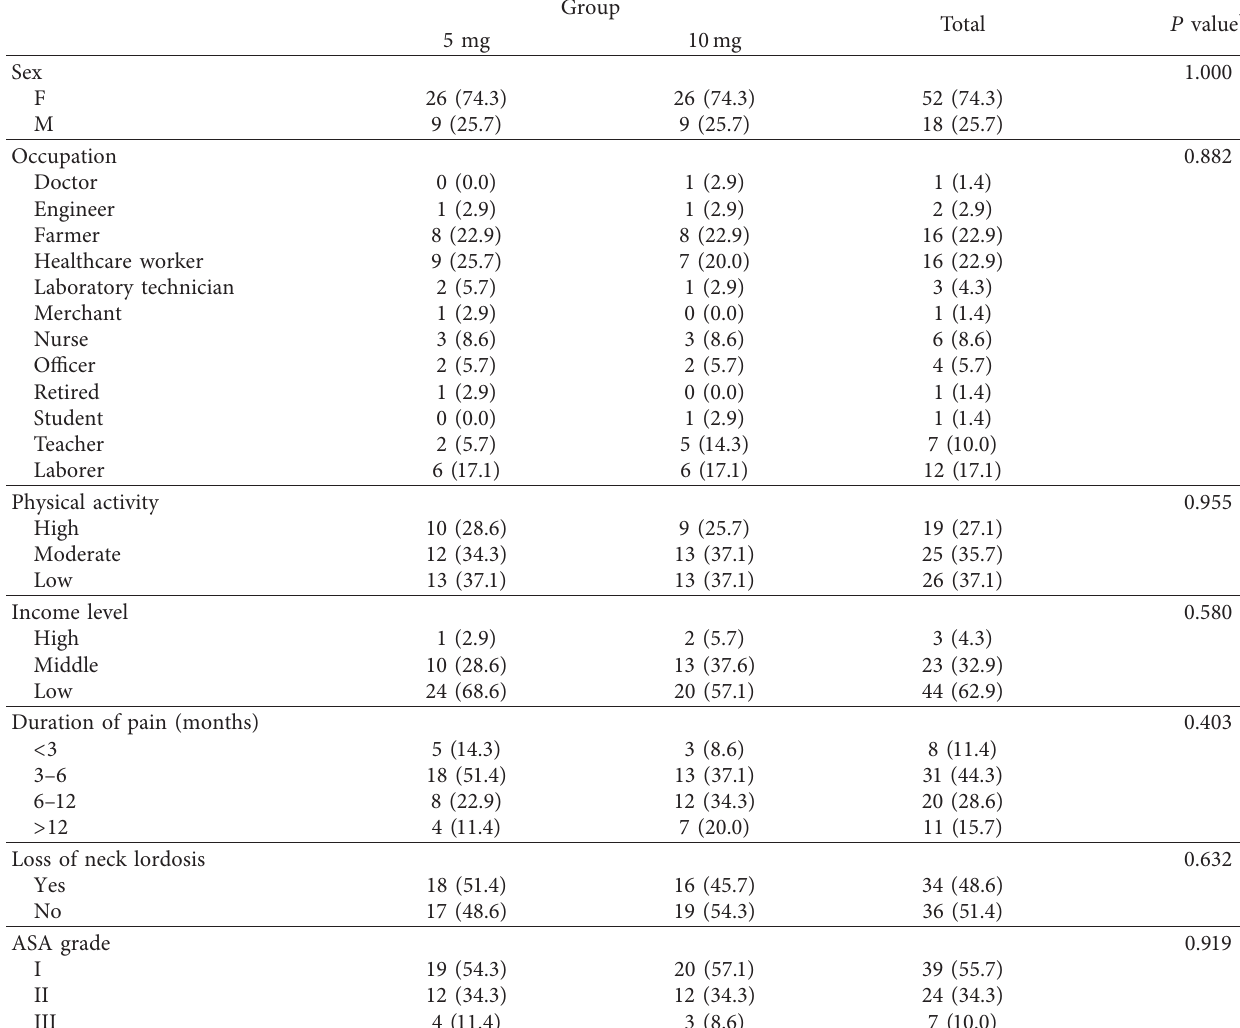
Table 1: Demographic and baseline characteristics of the study participants.